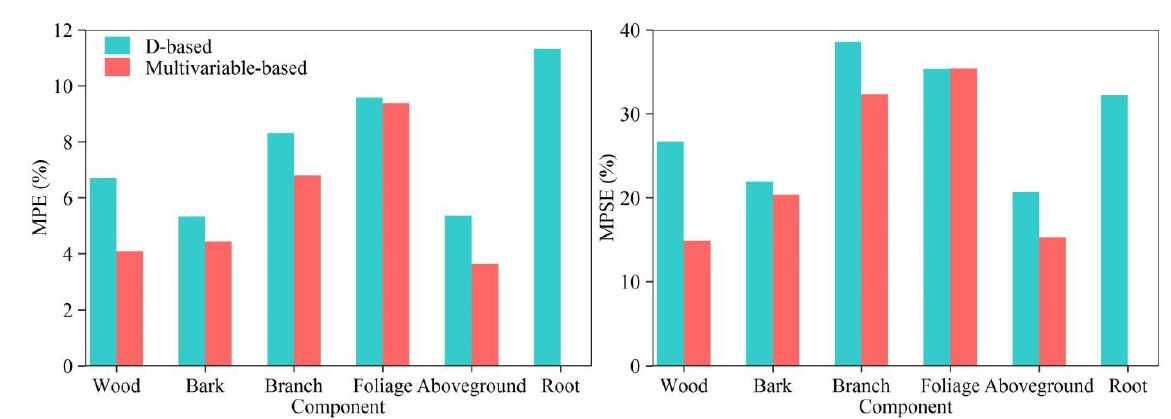
Figure 6. Scatterplots of the predicted ( y -axis) and the observed ( x -axis) values for the wood, bark, branch, leaf, above- ground and root biomass using the leave-one-out cross-validation method.